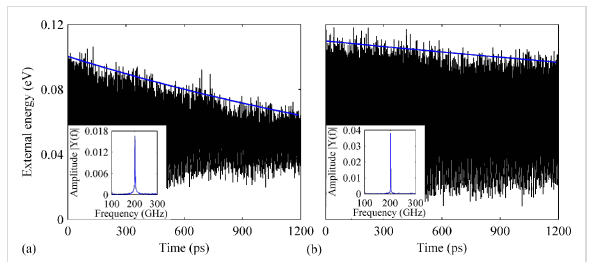
Different behaviors are also found for the other two samples with dopant densities of 1.77% and 2.02%. The results from the case with 2.02% dopants are given in Figure 7b. As clearly seen, the external energy exhibit a sharp initial damping from 0.11 to ca. 0.09 eV at the early stage of vibration (within 300 ps). Afterwards, it saturates around 0.09 eV. The corresponding resonance frequency is estimated to be 107